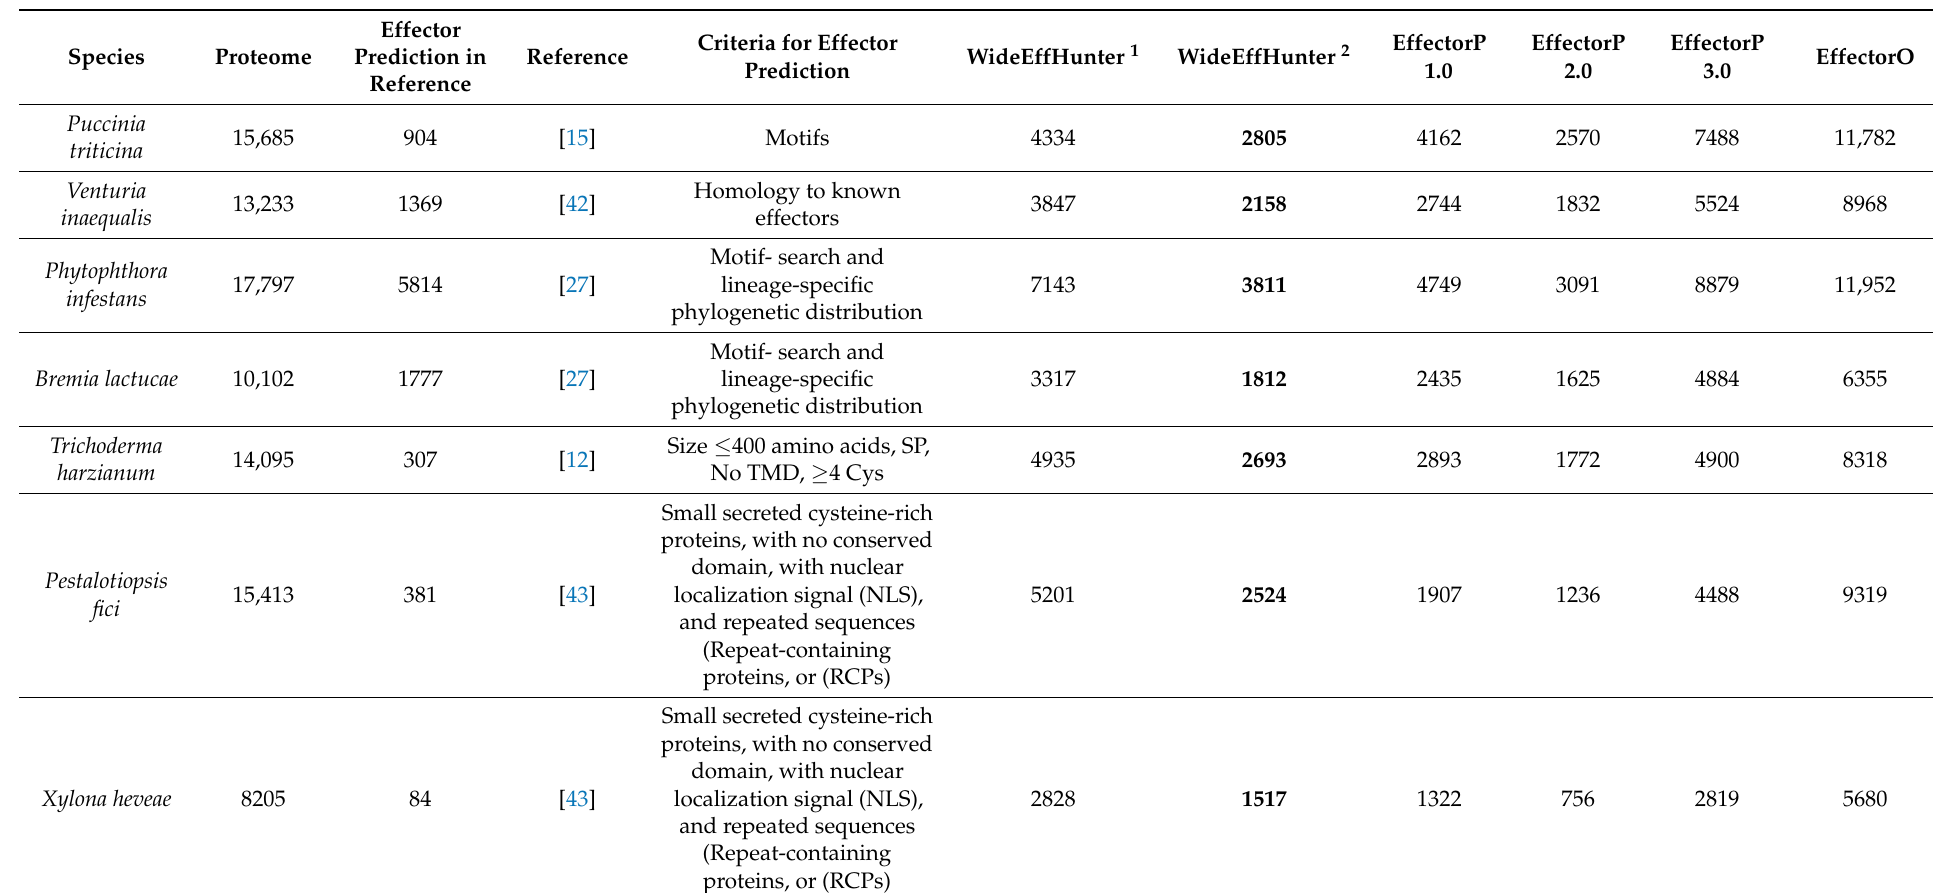
Table 8. Effectoromes predicted by WideEffHunter in selected fungi and oomycetes and comparison with other